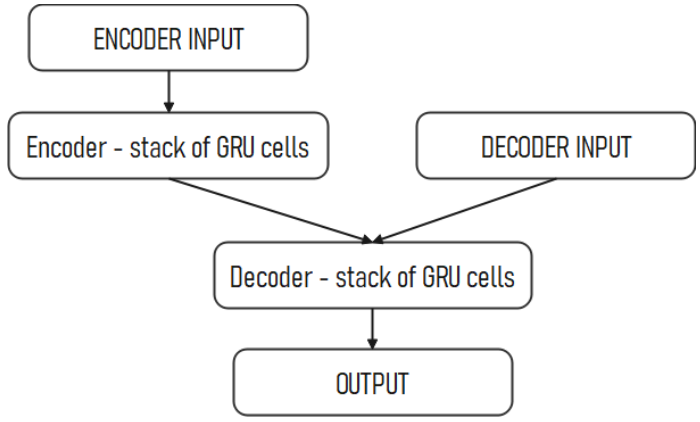
Figure 11. Encoder–decoder